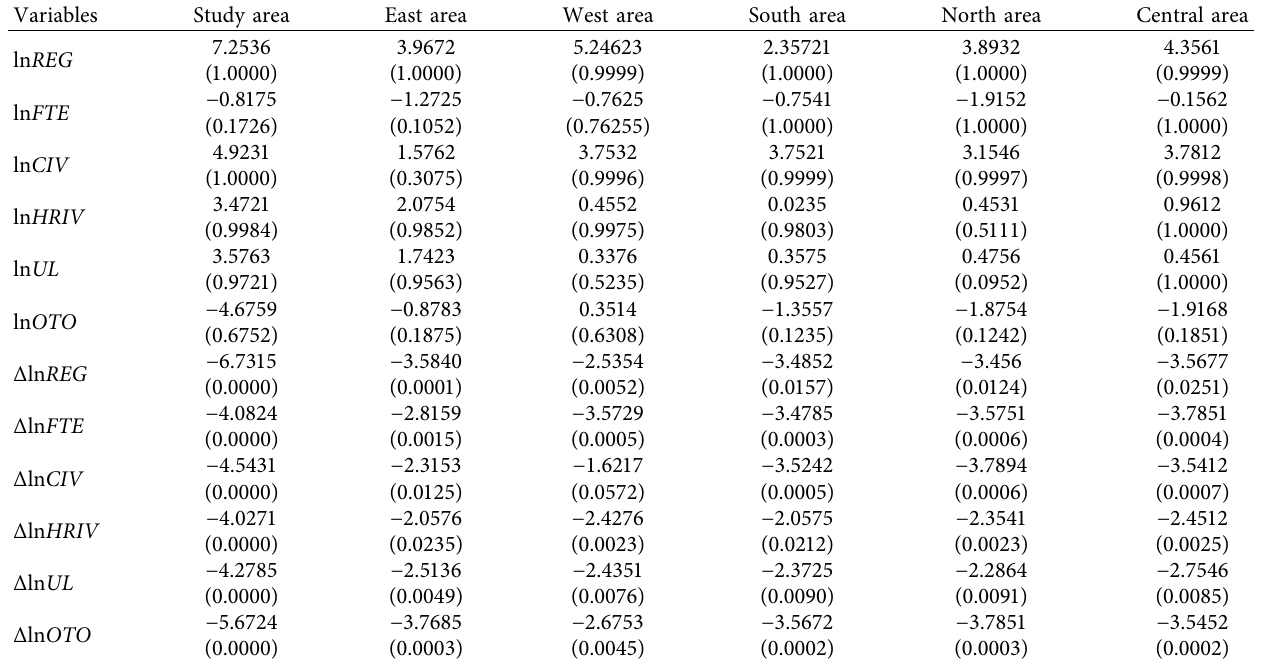
Table 7: Unit root test